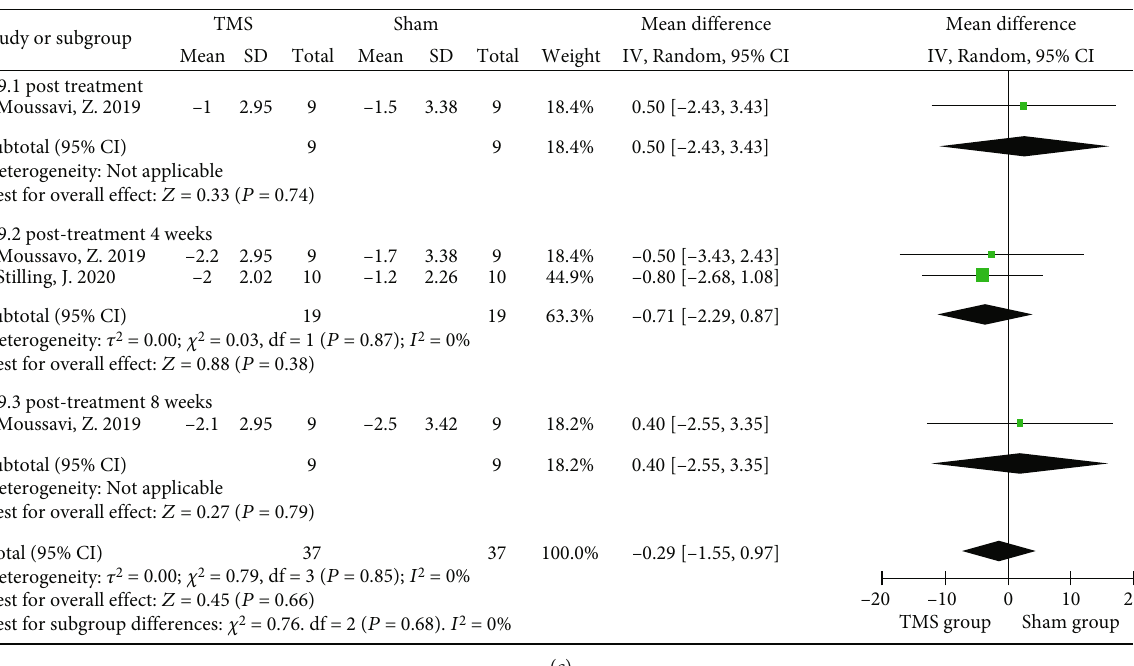
Figure 7: Forest plots of di ff erent parts of rTMS on the severity of di ff erent symptoms measured by the RPQ in TBI patients: (a) the RPQ; (b) the RPQ-13; (c) the RPQ-3. RPQ: Rivermead Post-Concussion CI -11.58 to -1.46, P = 0 : 01 ) (Figure 4(b)) [41]. Similarly, no